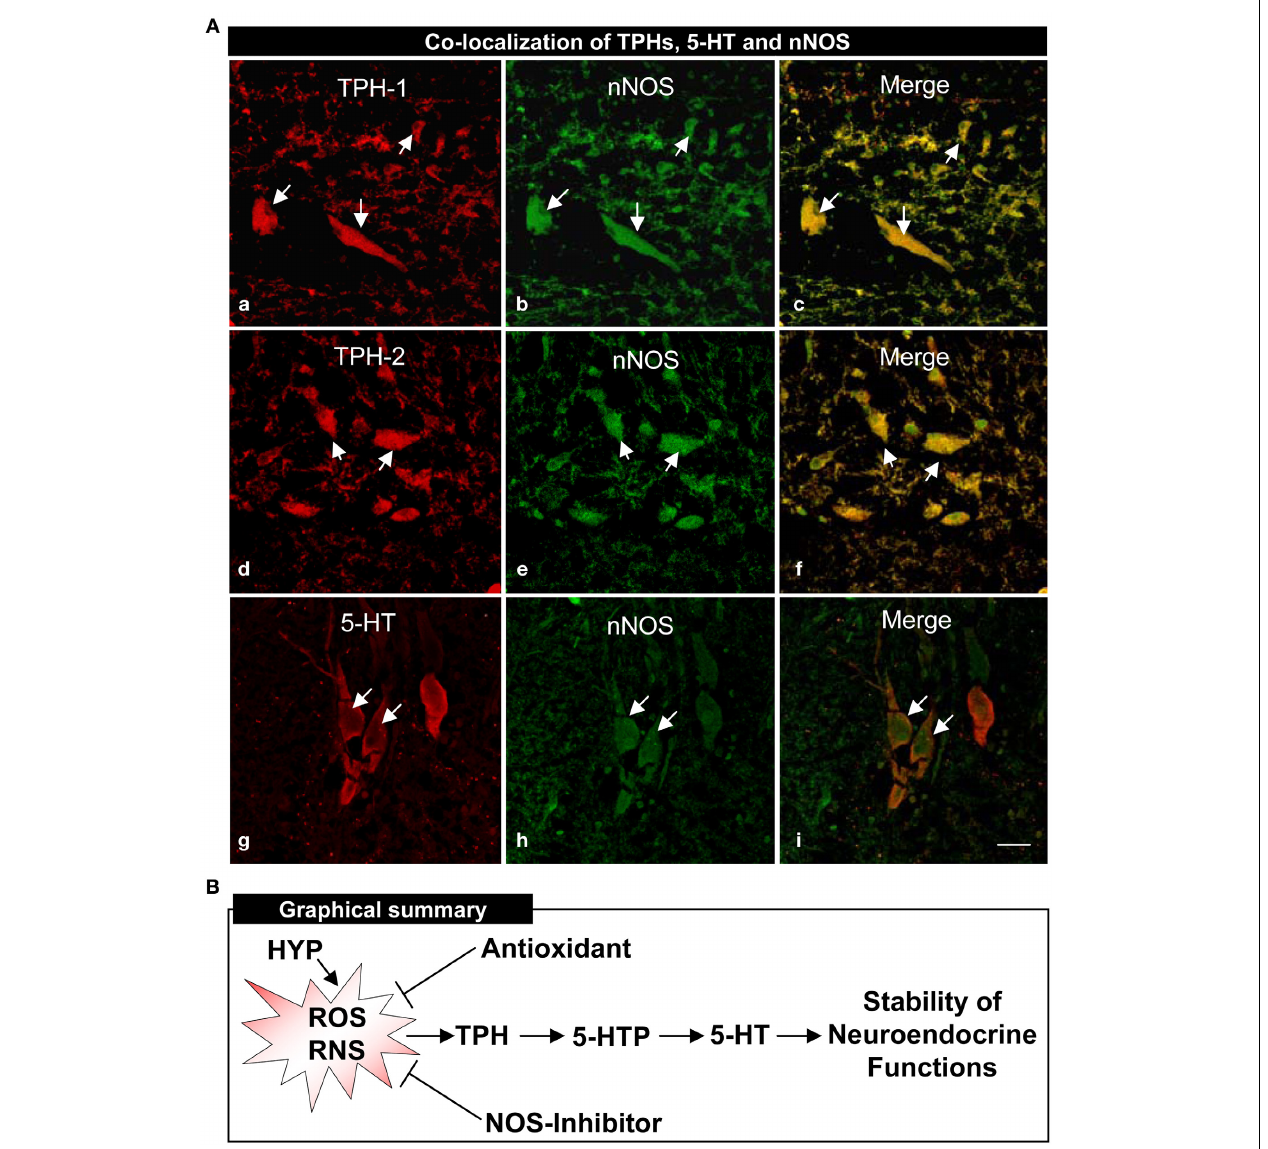
FIGURE7|Co-localization of TPHs and 5-HT neurons on neuronal nitric oxide synthase (nNOS) determined by double-immunofluorescence in croaker hypothalamus and proposed model of their interactions (A). Immunohistochemical co-localization of TPH-1 (a–c) , TPH-2 (d–f) and 5-HT (g–i) neurons with nNOS neurons. Scale bar = 5 μ m. Arrows indicate neuronal expression of TPH-1, TPH-2, 5-HT, nNOS and their co-expression.